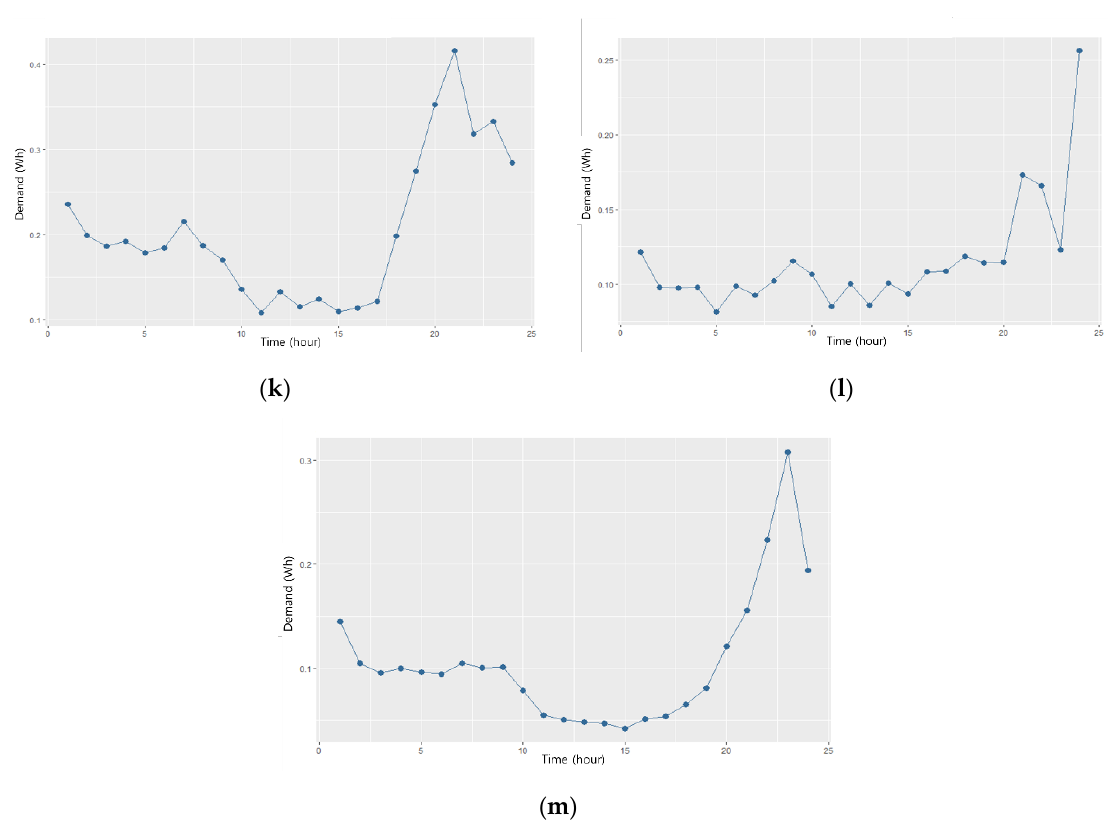
Figure 6. L oad profiles of customer segmentation results by the proposed clustering methodology: ( a ) group 1; ( b ) group 2; ( c ) group 3; ( d ) group 4; ( e ) group 5; ( f ) group 6; ( g ) group 7; ( h ) group 8; ( i ) group 9; ( j ) group 10; ( k ) group 11; ( l ) group 12; ( m ) group 13.